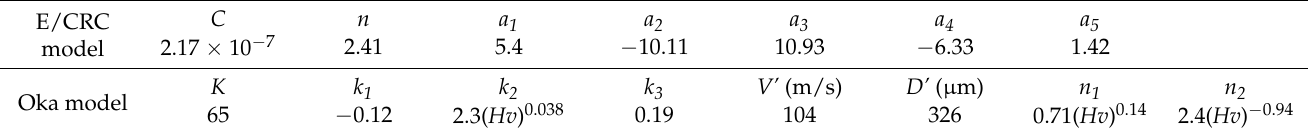
Table 1. The related parameters in erosion